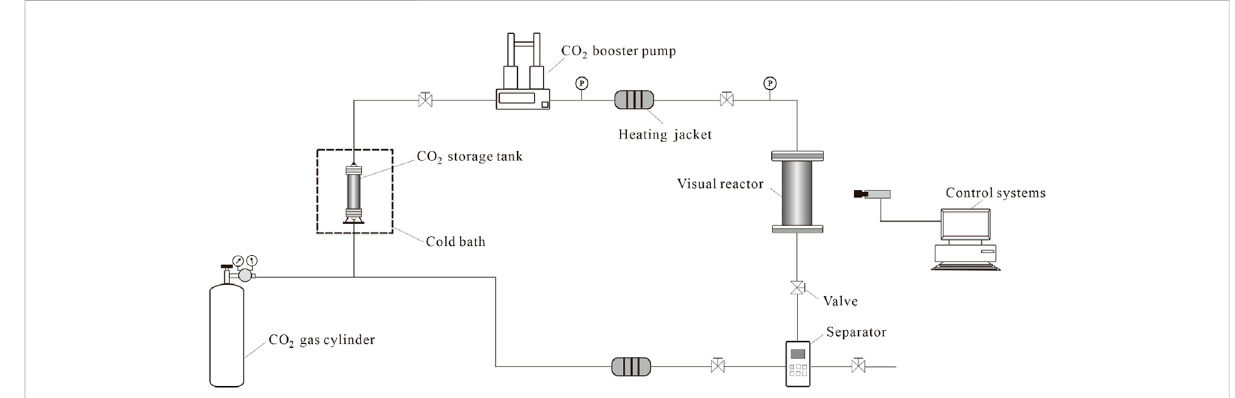
FIGURE 4 Visualization device for rock and supercritical CO 2 interactions fl ow chart.